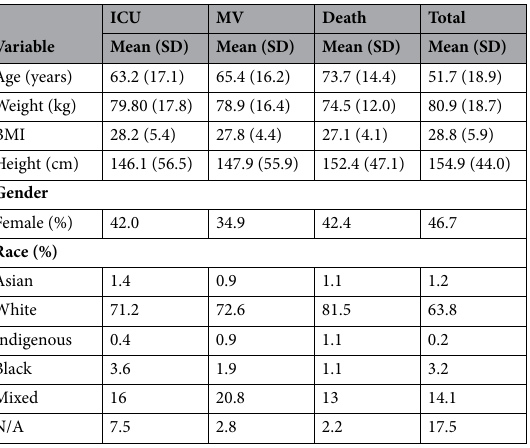
Table 1. Descriptive statistics of the demographics characteristics of the sample, BP Hospital—A Beneficência Portuguesa de São Paulo, Brazil,